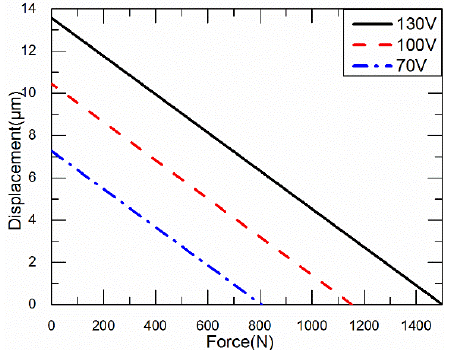
Figure 4. Relationship between the force and displacement under different working voltages.